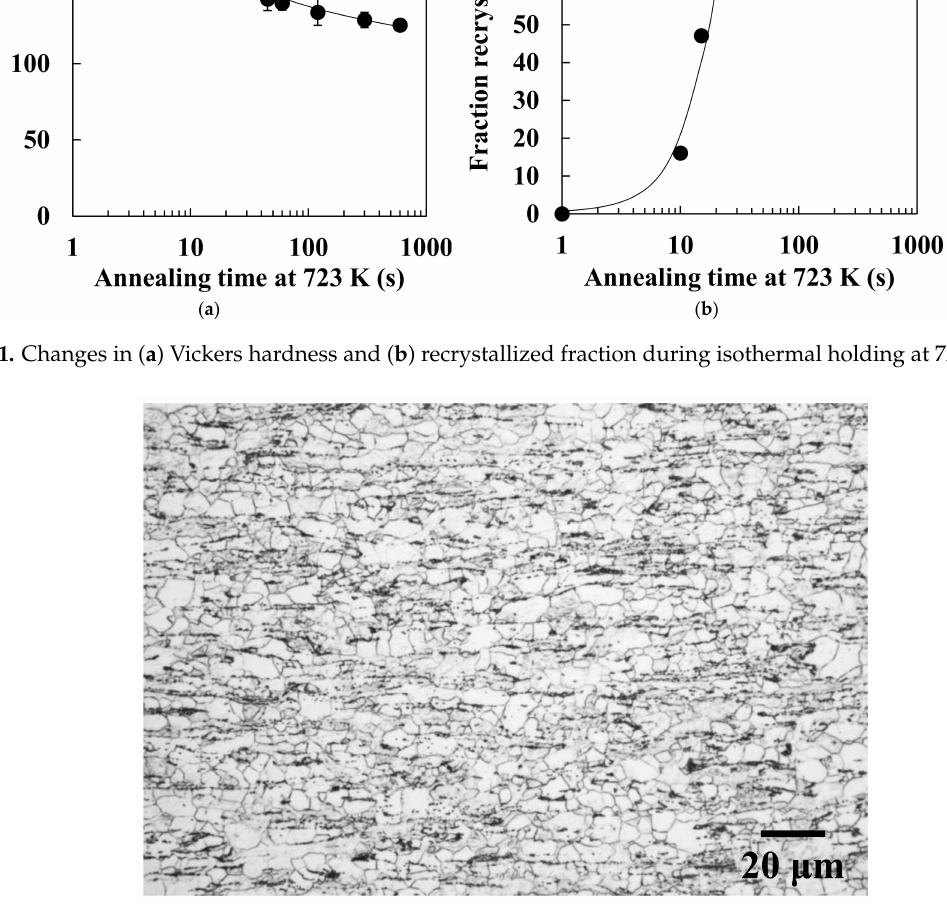
Figure 2. Microstructure of specimens annealed at 723 K for 45